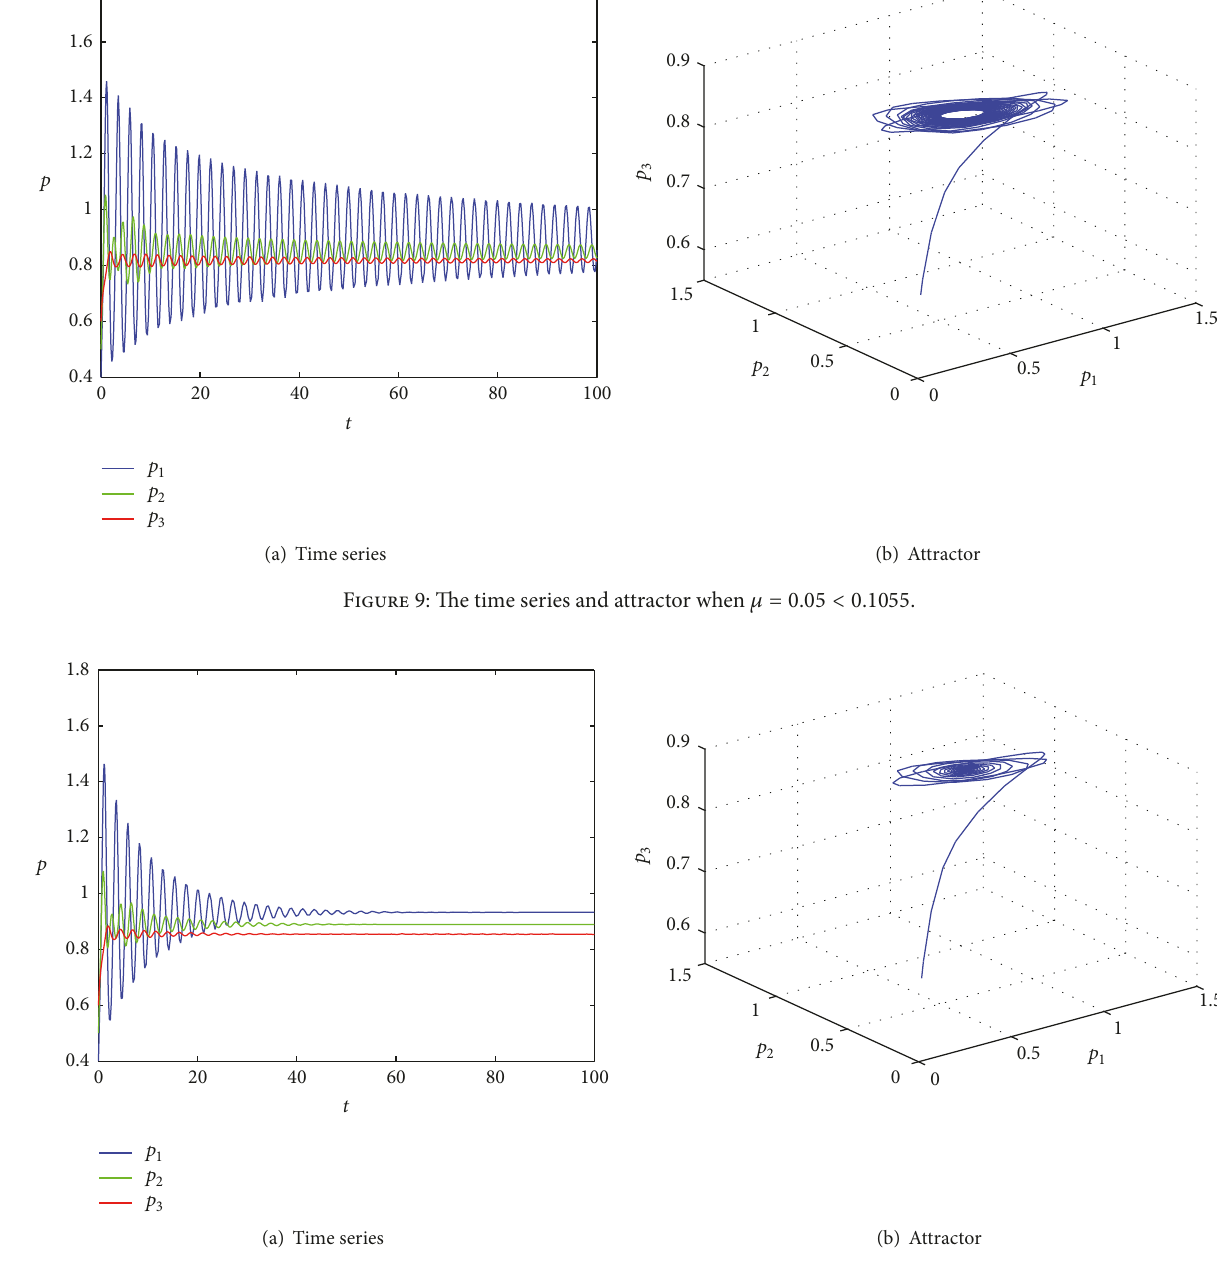
Figure 10: The time series and attractor when 𝜇 = 0.15 > 0.1055